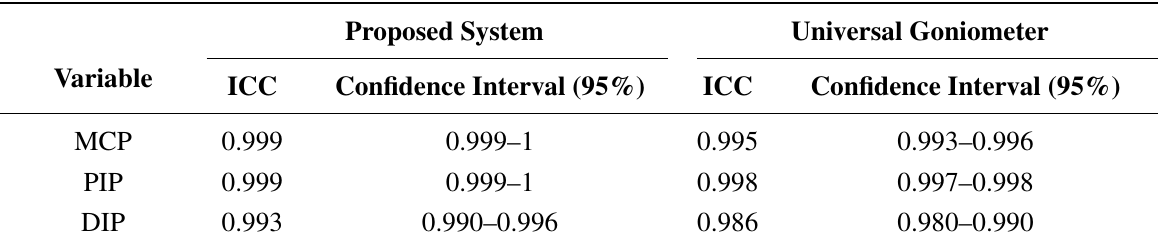
Table 3. The internal reliability of the proposed system. ICC, intraclass correlation coefficient.